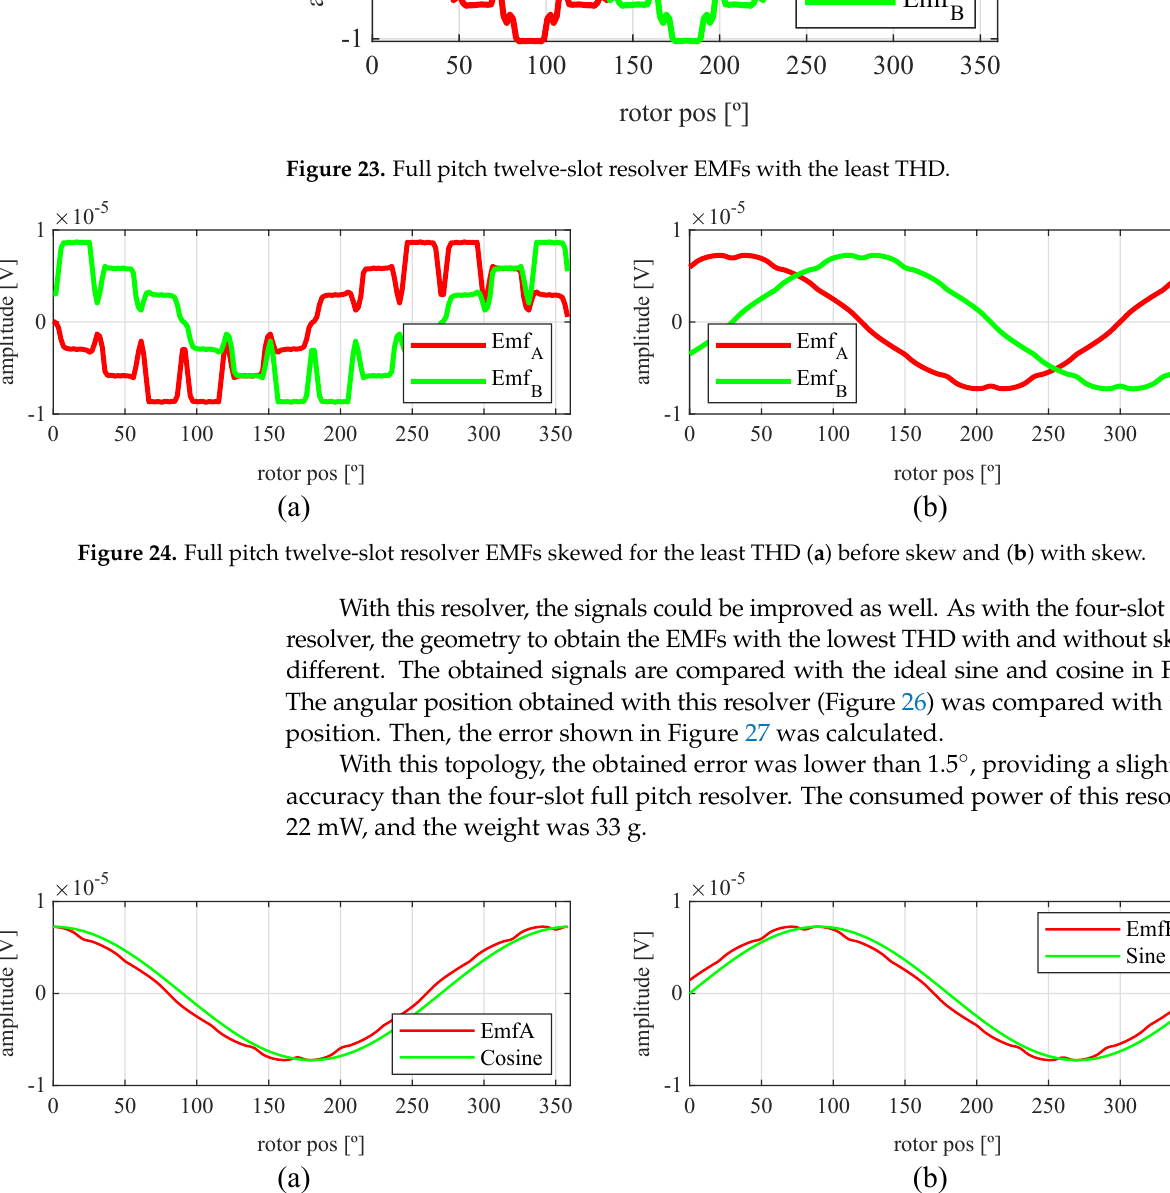
Figure 25. Full pitch twelve-slot skewed resolver EMFs vs. ideal signals ( a ) EMF A vs. Cosine and ( b ) EMF B vs.